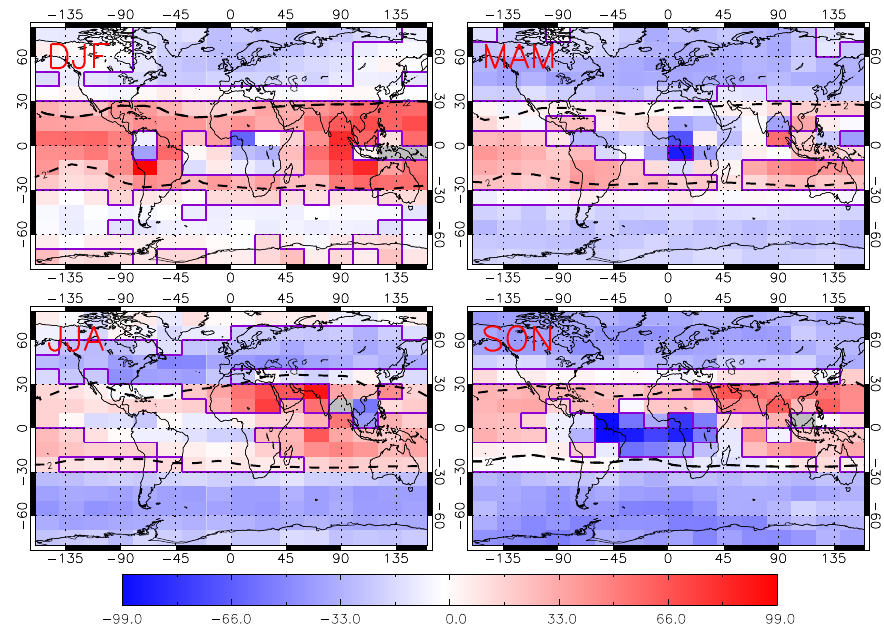
Figure 13. As Fig. 12 but for UoL MIPAS observations and application of the UoL averaging kernels to the TOMCAT model output.